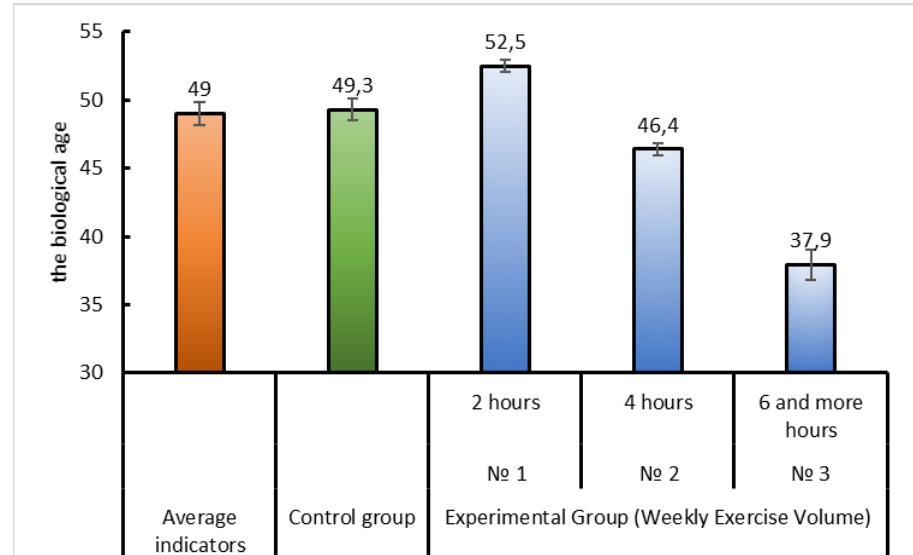
Fig.1. The dependence of the indicators of biological age of 1 st year boys on the weekly amount of physical activity during the school year [n =182]